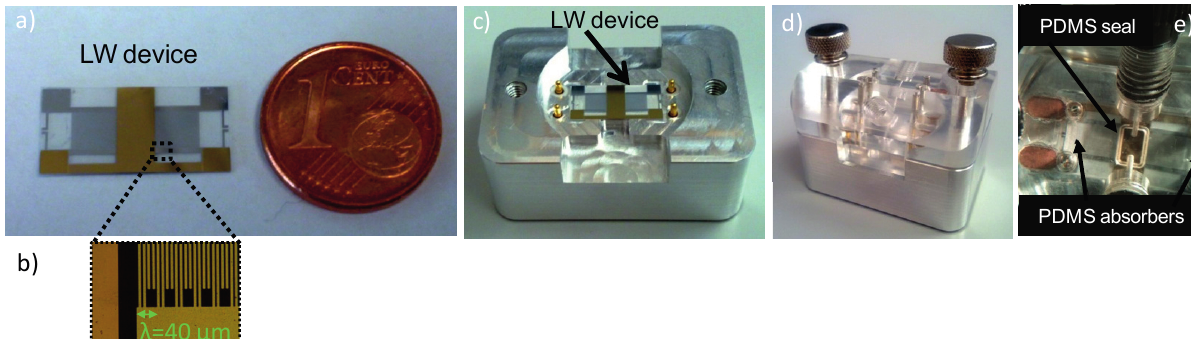
Figure 2. ( a ) Size comparison of the final fabricated LW device with a one centime euro coin; ( b ) Microscope picture of the IDTs fingers; ( c ) Lower part of the flow cell with sensor mounted; ( d ) Custom-made flow cell; ( e ) The sensing area sealing and PDMS absorbers seen from a microscope through the upper part of the flow-through